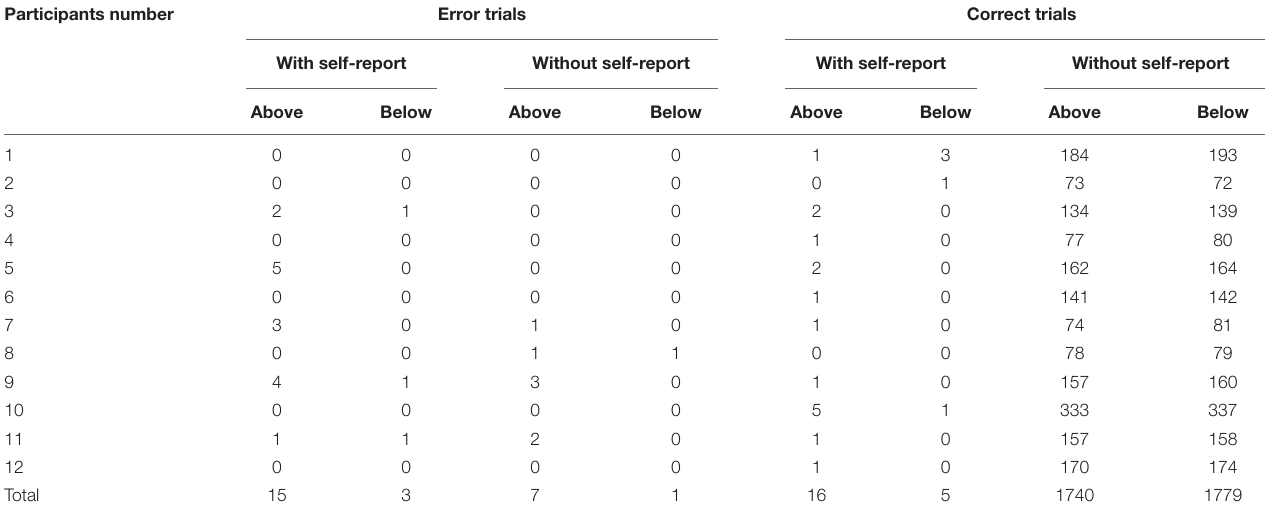
TABLE 1 | Number of trials in different conditions (Error or Correct trials, with or without self-report, Above or Below). Participants number